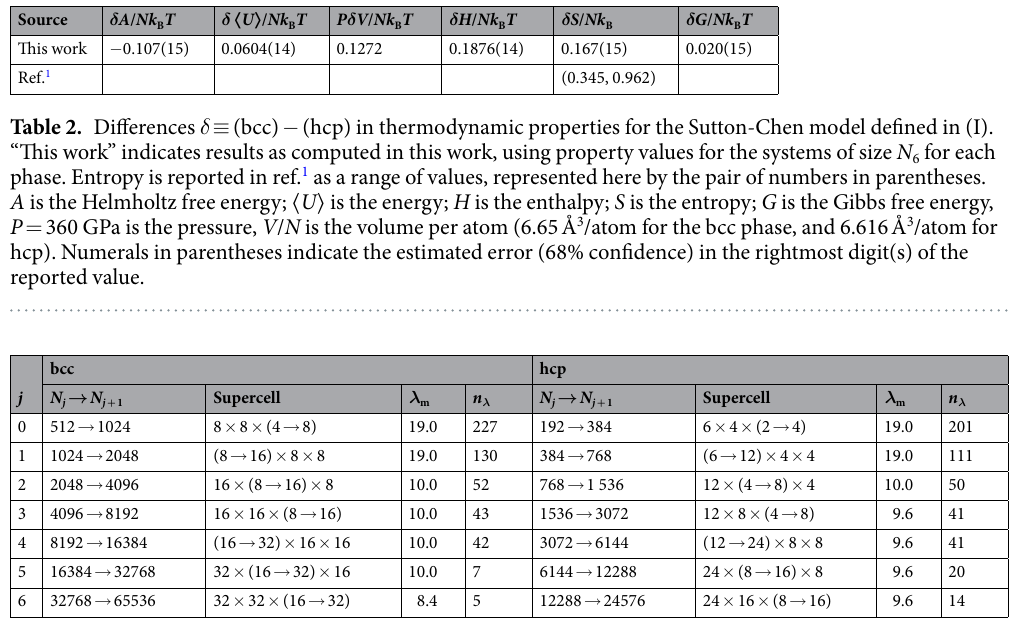
Table 3. System sizes and integration parameters used in this study. In each case, simulations were performed using the number of atoms indicated as N j + 1 ( = 2 N j ). Integration is performed for λ from 0 to λ m , using n λ steps, and yields Δ A ( N j ) ≡ A ( N j + 1 ) − A ( N j ). For hcp, λ steps are equally spaced, but in bcc the separation varies along the path.